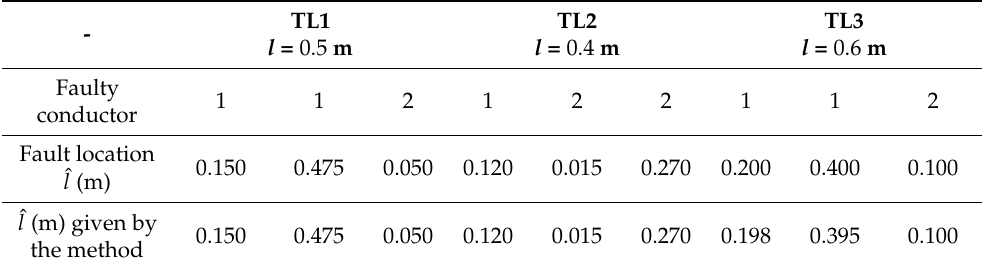
Table 5. Results of open faults diagnoses in the circuit shown in Figure